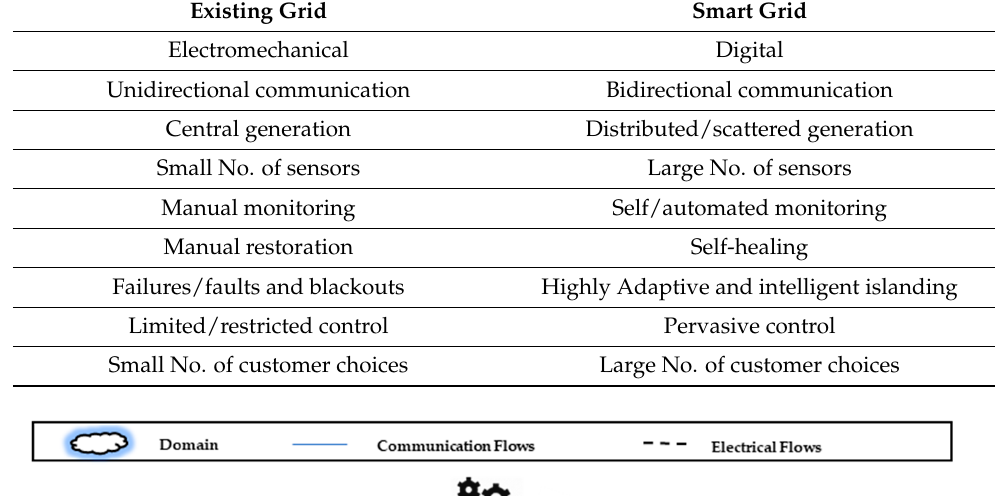
Table 1. Comparison between conventional and smart grids [43].